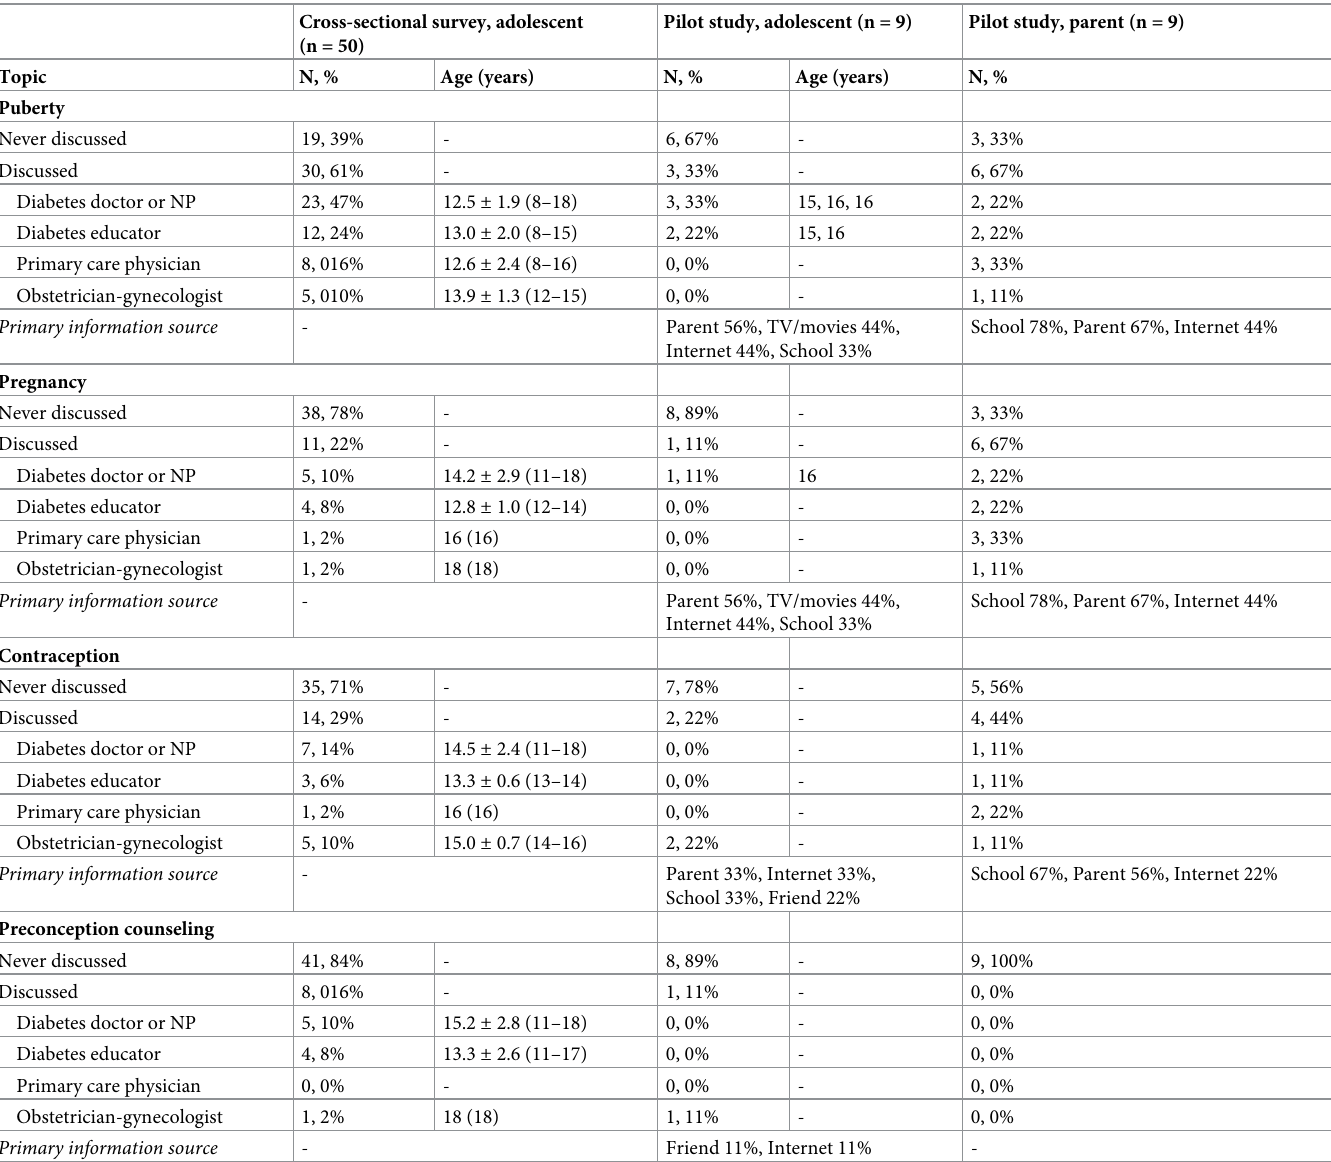
Table 3. Previous experiences with RHE. Shown as N, % or mean ± SD (range). Cross-sectional survey, adolescent (n =